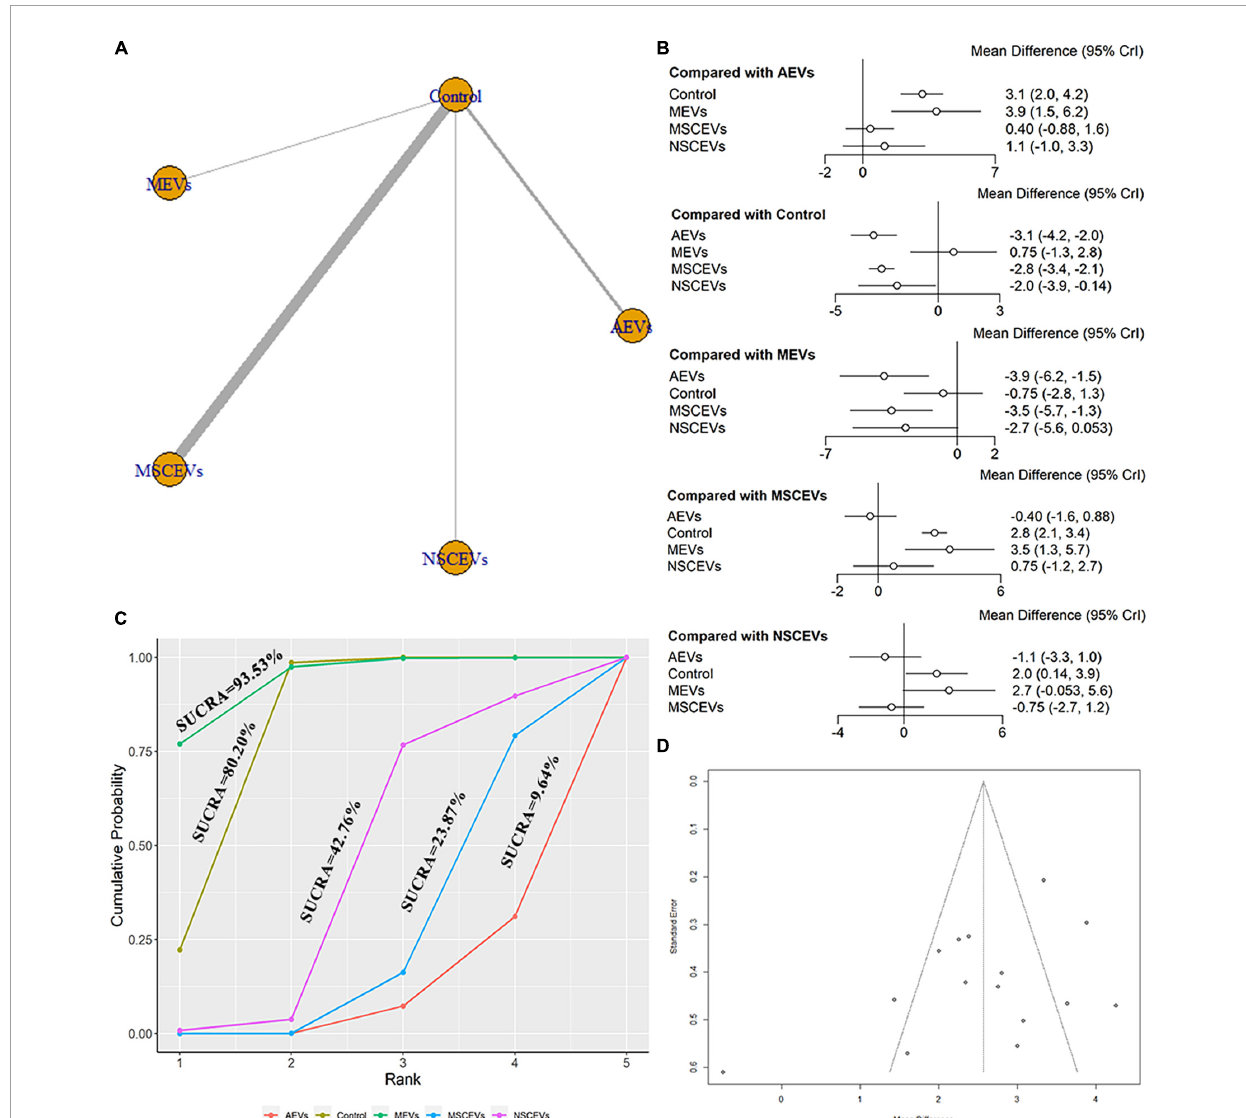
FIGURE4 Comparison of the efficacy of extracellular vesicles (EVs) from different cell sources in mNSS at day 7 post-traumatic brain injury (TBI). (A) Network plot; (B) Forest plot; (C) Surface under the cumulative ranking curves (SUCRA); (D) Funnel plot. The dotted lines represent 95% confidence interval (95% CI). AEVs, astrocyte-derived extracellular vesicles; MEVs, microglia-derived extracellular vesicles; MSCEVs, mesenchymal stem cell-derived extracellular vesicles; NSCEVs, neural stem cell-derived extracellular